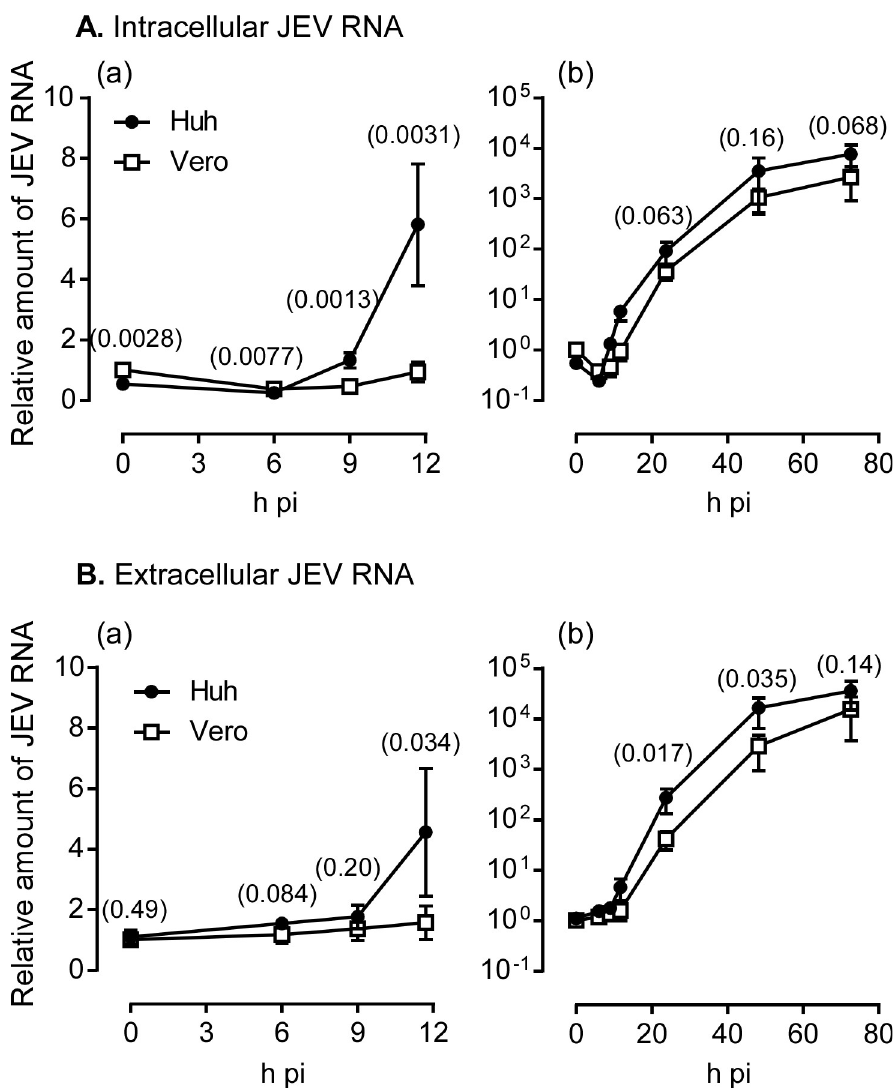
harvested at 0, 6, 9, 12, 24, 48, and 73 h pi, and RNA was purified. Viral RNA copy number in each RNA fraction was determined by qRT-PCR. The copy number of intracellular viral RNA was normalized by that of GAPDH RNA in the same fraction, whereas the amount of extracellular viral RNA was expressed as the total copy number in the culture supernatant of each well. The relative amounts of intracellular (A) and extracellular (B) viral RNA were calculated by dividing each value by that of Vero cells at 0 h pi in the same experiment. Data represent the mean ± SD of the relative values from four independent experiments. Graph (a) is an enlarged view of 0 − 12 h pi drawn on a linear scale, whereas graph (b) is a whole view drawn on a log scale. Some error bars are not visible due to their small size. Statistical significance was determined by a one-sample t test (0 h pi) or an unpaired two-tailed t test (other time points). Values in parentheses indicate p values, and those less than 0.05 were considered statistically significant. Huh, Huh7.5.1–8